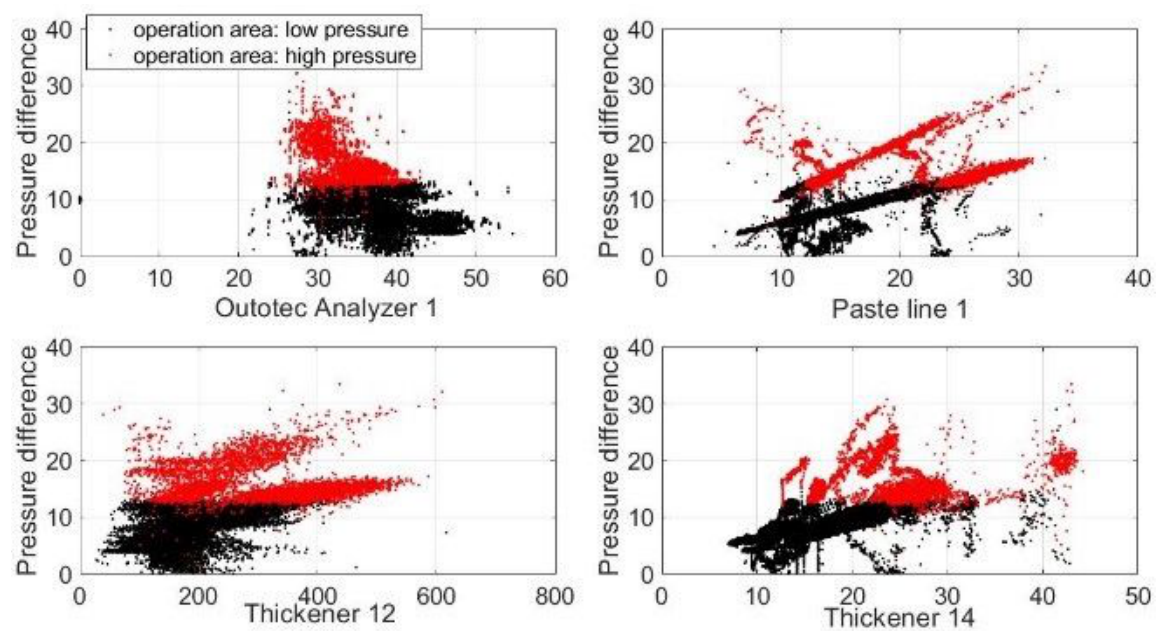
Figure 4: Scatter graphs between variables: Outotec Analyzer 1, Paste line 1, Thickener 12, Thickener 14 and response during the usage of booster pump